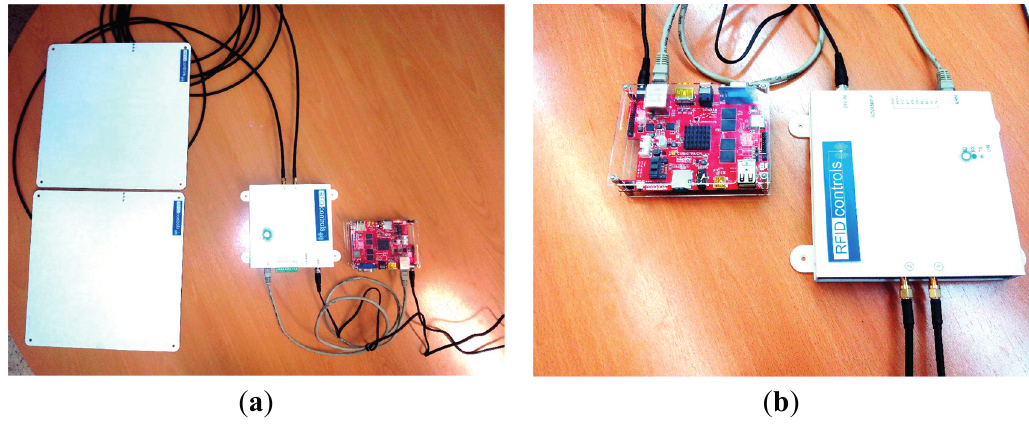
Figure 12. RFID Smart Sensor prototype: ( a ) RFID Smart Sensor with antennas; ( b ) RFID reader with an embedded